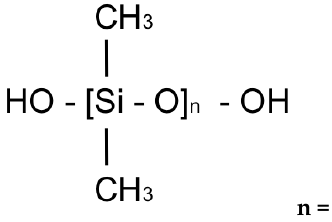
Scheme 4. Structure of low molecular plasticizer.